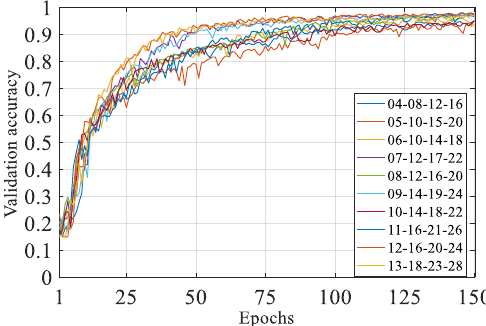
ff erent structural neural network models.